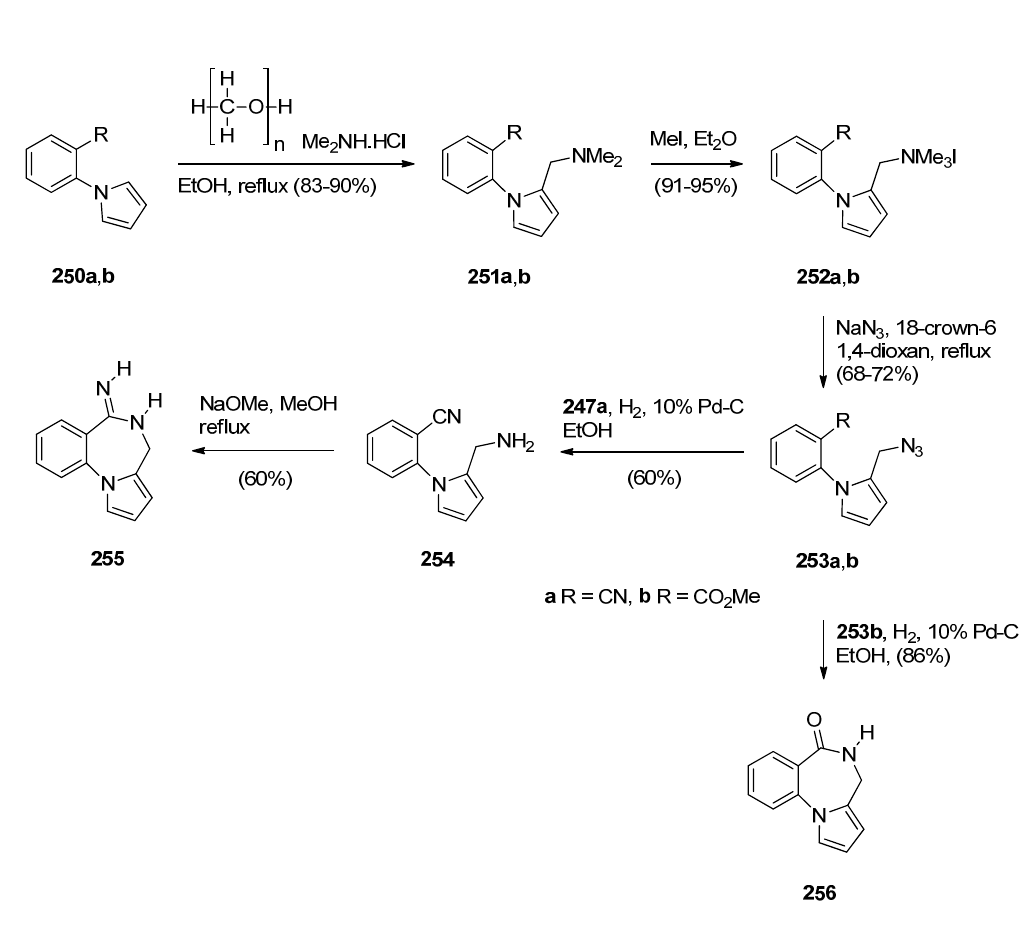
Scheme 46. Synthesis of PBD derivatives 255 and 256